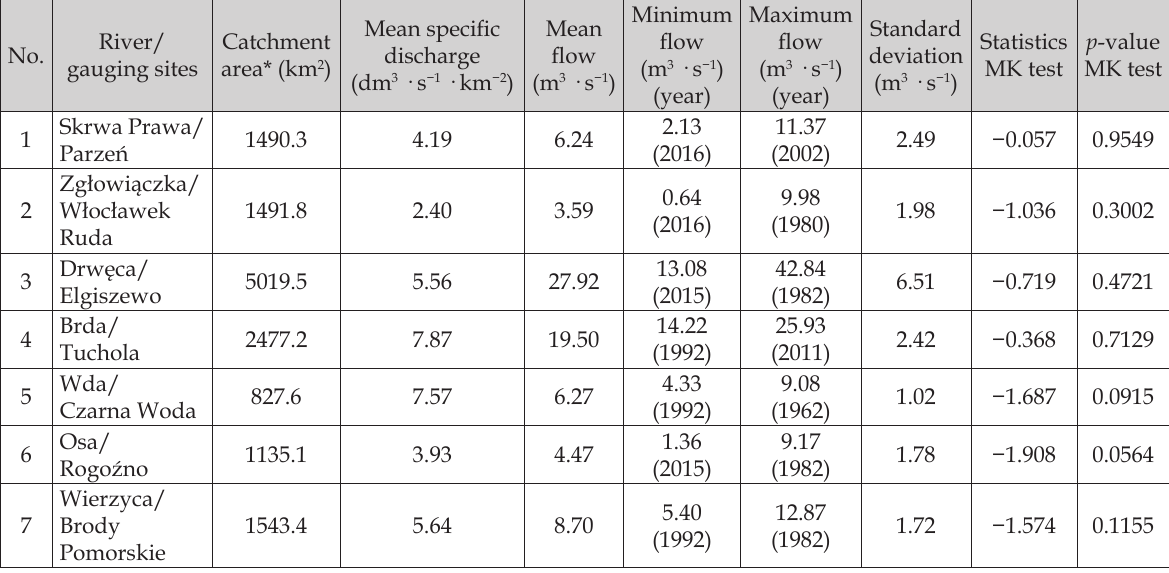
Fig. 1. Research Area. explanations: Numbering of gauging sites according to Table Table 1. Basic statistics of the mean annual flow of the studied rivers and the p -value of the MK test for trend in 1954–2018.